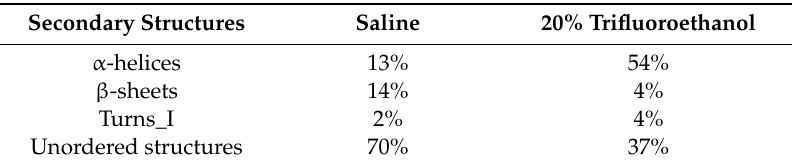
Table 1. Circular dichroism spectra of the TBI_tag protein. Table 1 . Circular dichroism spectra of the TBI_tag protein.